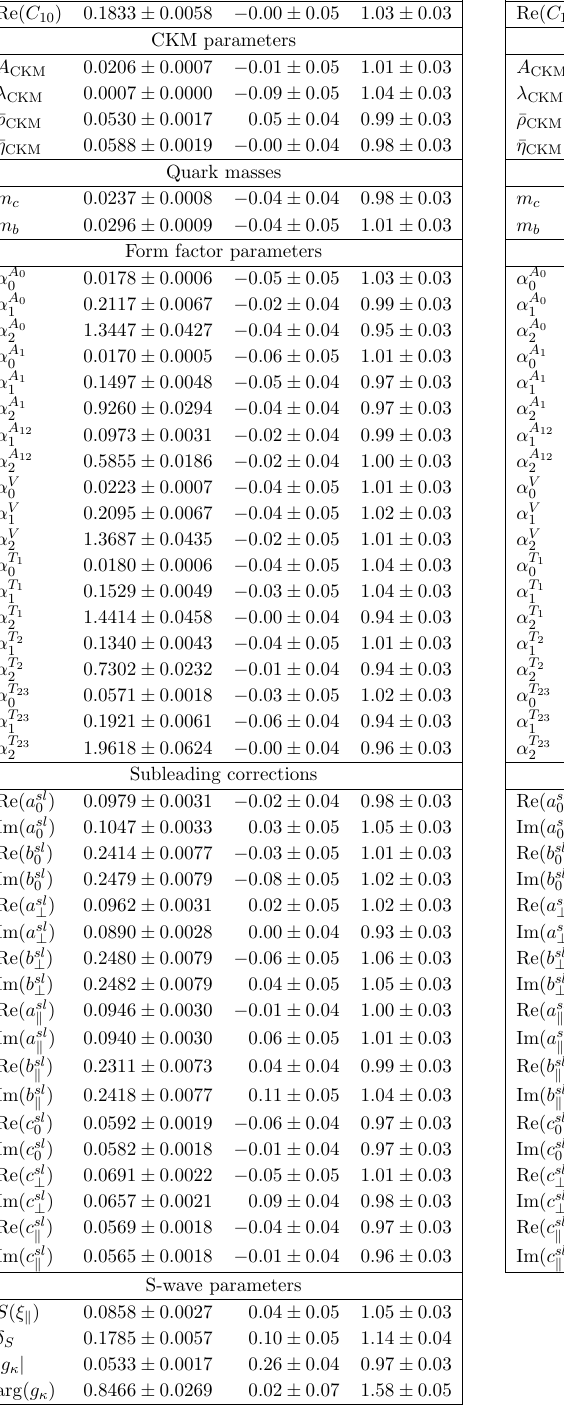
Table 7. Results from pseudoexperiments determining Re( C 10 ) using (left) the proposed direct (cid:12)t method and (right) the q 2 -binned approach.